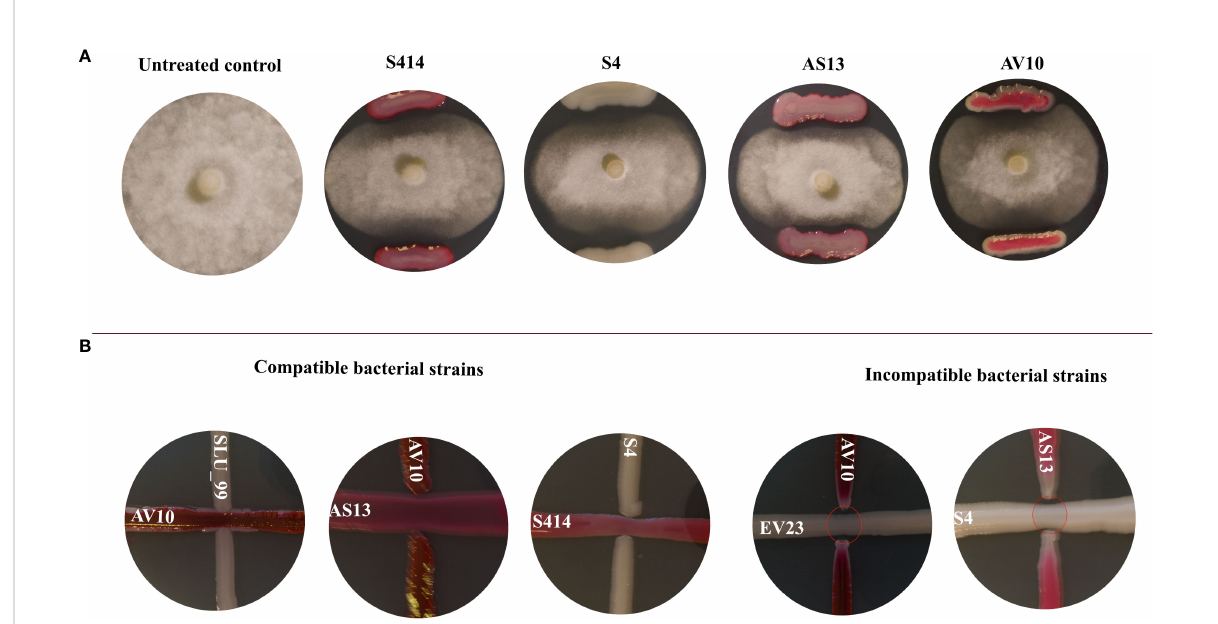
FIGURE 1 (A) Inhibition of Phytophthora colocasiae mycelia growth in dual culture assay. Control culture of P. colocasiae exhibited uniform hyphal growth, with the formation of abundant aerial hyphae and sporangiophores. Co-culture with biocontrol bacteria led to inhibition of radial hyphal growth and reduced formation of aerial structures; (B) Compatibility assay between co-inoculated strains. The strains were streaked at 90